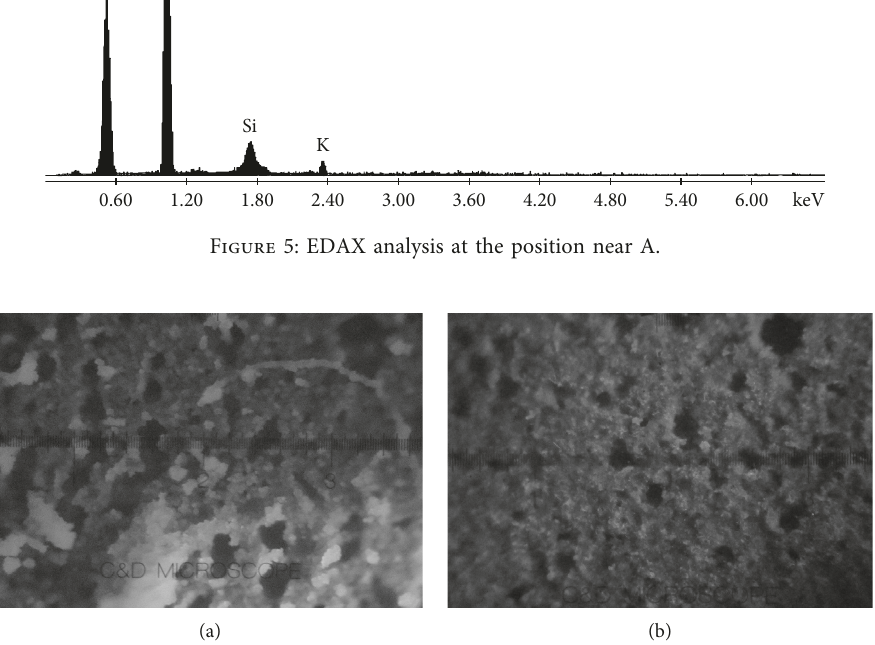
Figure 6: Optical microscopy (10x magnification). Sample SMF1 (a) and sample SMSB2 (b) after 30